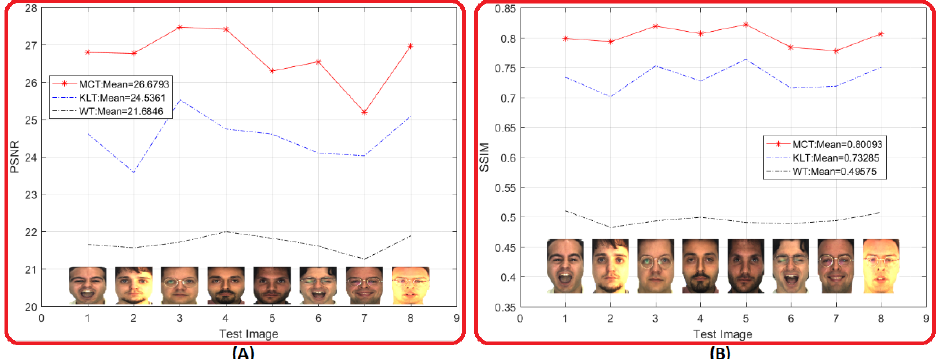
Figure 14. A metric comparative evaluation applied on 8 random facial images of warp face dataset of AR database. ( A ) PSNR and ( B ) SSIM.